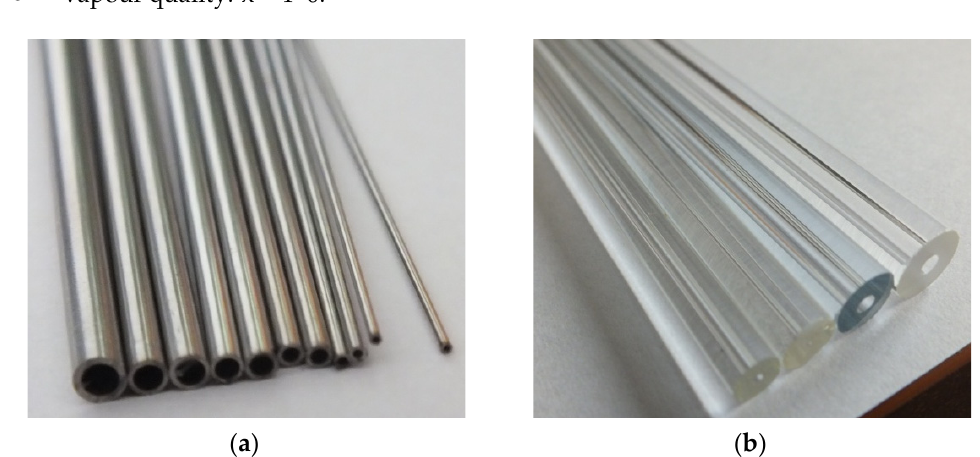
Figure 4. View of mini-channels ( a ) made of stainless steel ̶ for thermal tests, ( b ) glass ̶ for visualization tests.